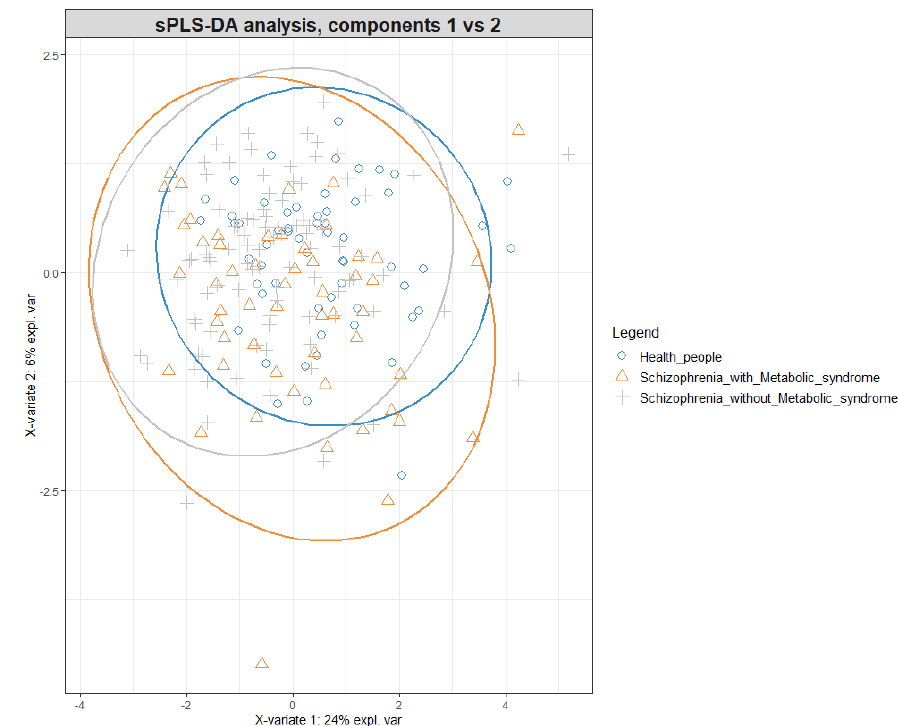
Figure 1. The scatter plot of 73 individuals on the basis of the first two principal components derived from concentrations of the assayed amino acids and acylcarnitines by sPLS-DA. The levels of amino acids and acylcarnitines in patients with schizophrenia with or without MetS and in healthy individuals are presented in Table 2. Acylcarnitine C5, leu- cine/isoleucine, and alanine levels proved to be elevated in patients with MetS compared with the schizophrenia group without MetS. We detected lower concentrations of acyl- carnitines C10 ( р = 0.018 and 0.006, respectively), C10:1 ( р = 0.009 and 0.003, respectively), C12 ( р = 0.046 and 0.033, respectively), and C18 ( р = 0.003 and 0.0001, respectively) in the patients with MetS and those without MetS in comparison with healthy controls. Addi- tionally, in paranoid schizophrenia without MetS, there were lower levels of acyl- carnitines C5 ( р = 0.0001), C5:1 ( р = 0.003), and C14 ( р = 0.018) relative to healthy volun- teers. The alanine concentration was statistically significantly higher in patients with paranoid schizophrenia comorbid with MetS as compared with healthy individuals ( p = 0.044). Table 2. Levels of amino acids and acylcarnitines in the patients with schizophrenia and healthy individuals included in the study.